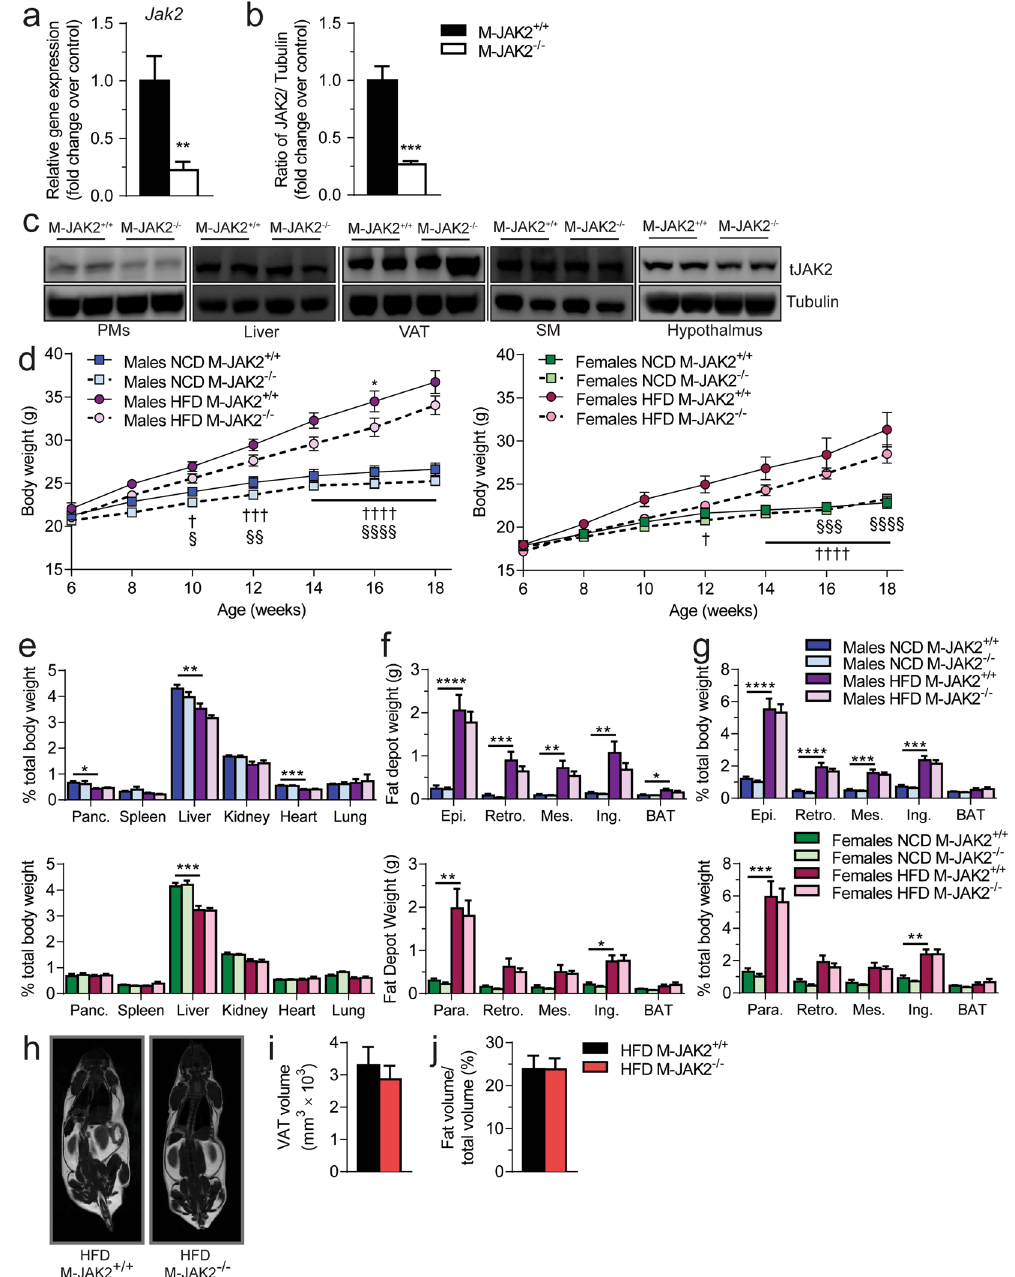
Figure 1. Generation and characterization of M-JAK2 + / + and M-JAK2 − / − mice. ( a ) mRNA expression and ( b ) protein levels for JAK2 in thioglycolate-elicited peritoneal macrophages (PMs) from 8- to 10-week old M-JAK2 + / + and M-JAK2 − / − mice (n = 6–7). ( c ) Representative Western blots of protein lysates from PMs, liver, visceral adipose tissue (VAT), skeletal muscle (SM), and hypothalamus from M-JAK2 + / + and M-JAK2 − / − mice for JAK2 and tubulin, as a loading control. Full blots in Supplementary Fig. S6. ( d ) Body weight measurements of male and female M-JAK2 + / + and M-JAK2 − / − mice fed NCD (n = 12-13 males, n = 12–13 females) or HFD (n = 13–14 males, n = 11–13 females); * HFD M-JAK2 + / + compared to HFD M-JAK2 − / − mice, † NCD M-JAK2 + / + compared to HFD M-JAK2 + / + mice, § NCD M-JAK2 − / − compared to HFD M-JAK2 − / − . ( e ) Tissue weights relative to total body weight of pancreas (Panc.), spleen, liver, kidney, heart, and lungs; and ( f ) absolute weights and ( g ) weights relative to total body weight of adipose depots: epidydimal (epi., male), parametrial (para., female), retroperitoneal (retro.), mesenteric (mes.), inguinal (ing.), and interscapular brown adipose tissue (BAT) in M-JAK2 + / + and M-JAK2 − / − male and female mice fed NCD (n = 5–8 males, n = 9 females) or HFD (n = 7–9 males, n = 10–11 females). ( h ) Representative image of whole animal MRI scan; ( i ) total VAT volume and ( j ) percentage of abdominal adipose volume relative to total body volume determined using MRI in M-JAK2 + / + and M-JAK2 − / − male mice fed HFD (n = 4). All results are mean ± SEM; * p < 0.05, ** p < 0.01, *** p < 0.001, **** p <